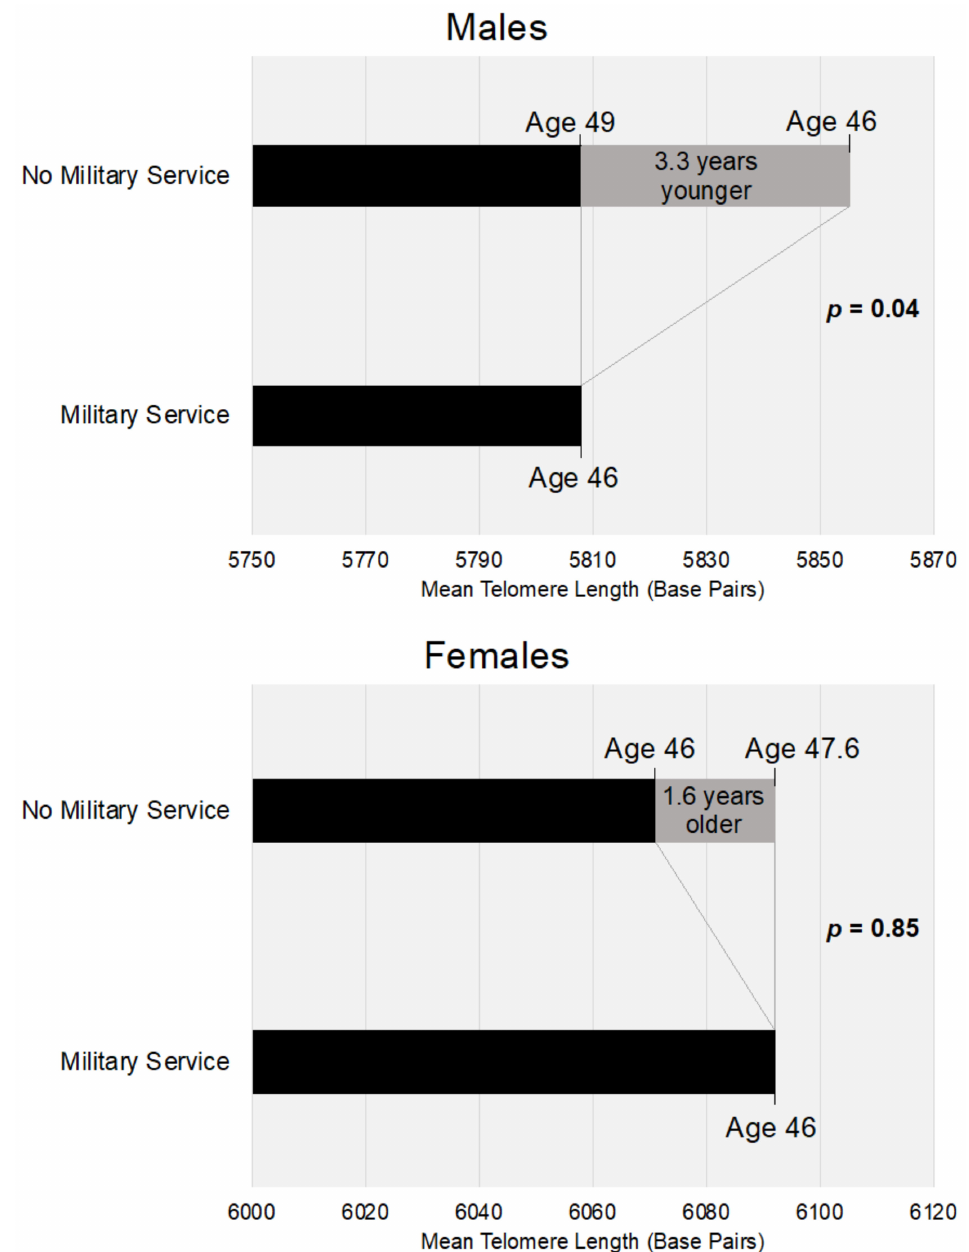
Figure 1. Multivariable regression-based mean telomere length in base pairs for males and females at mean sample age of 46 years, and mean values of covariates (black bars), with year equivalents of telomere difference between individuals with no military service (gray section of bar) compared to individuals with military